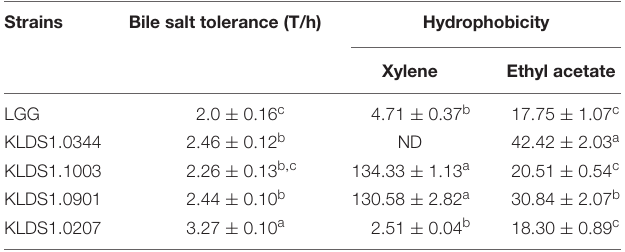
TABLE 3 | Comparison of Lactobacillus for their bile salt and acid tolerance and hydrophobicity. Strains Bile salt tolerance (T/h) Hydrophobicity